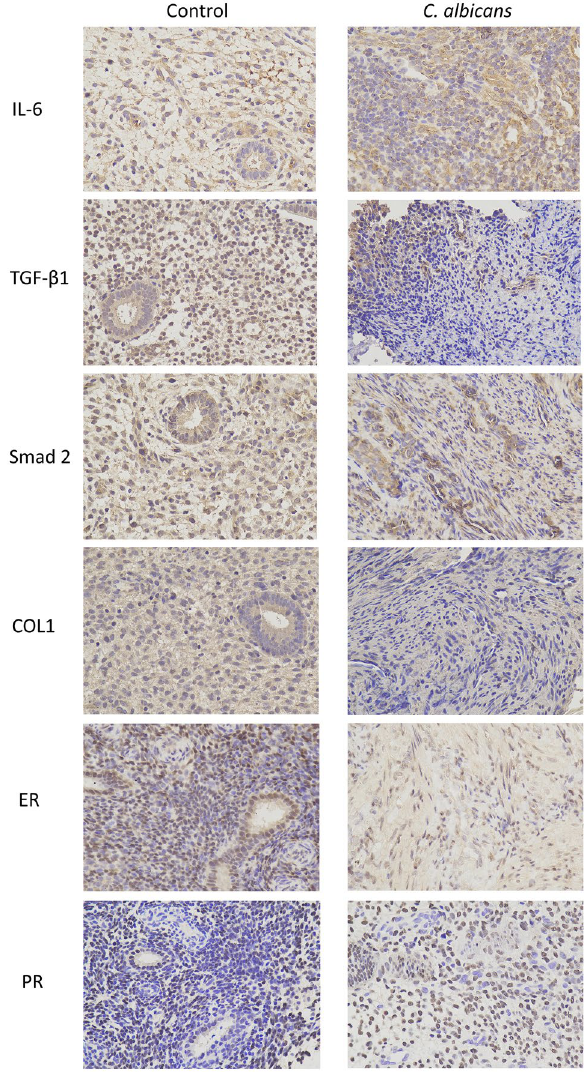
Figure 4. Immunohistochemical staining of IL-6, TGF-β1, Smad 2, COL1, ER, and PR in the C. albicans and control groups (×400). IL-6 interleukin-6, TGF-β1 transforming growth factor-β1, ER estrogen receptor, PR progesterone receptor.